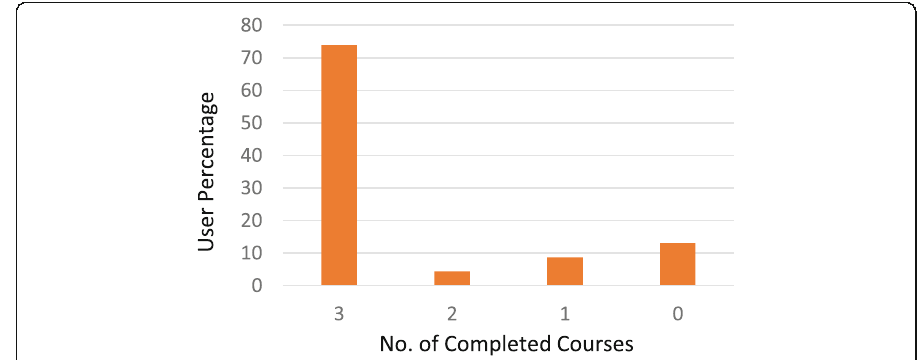
Fig. 11 The percentage of users vs. the number of courses taken in a single login attempt for users in January